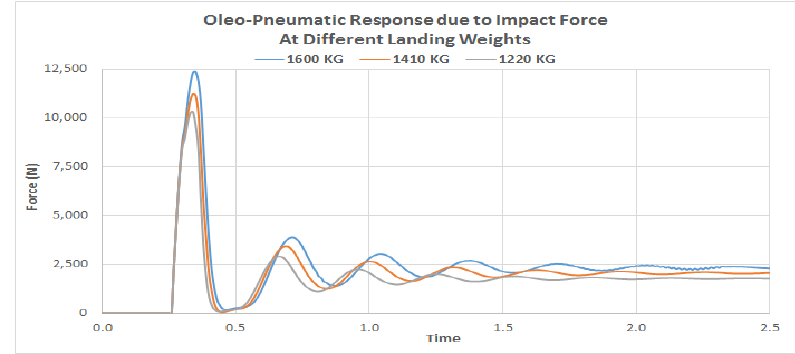
Figure 12. Vertical impact force recorded during drop test simulation.